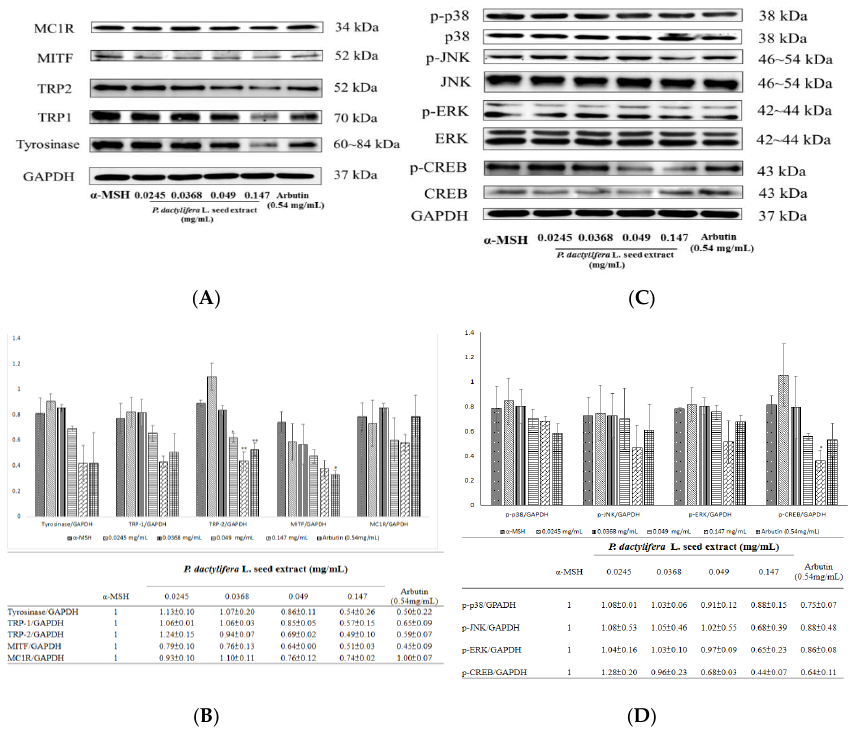
Figure 5. The effects of P. dactylifera L. seed extract on melanogenesis-related protein expression and signaling pathways. ( A , C ) Western blotting of cellular proteins in B16F10 cells. ( B , D ) The relative amounts of MITF, tyrosinase, MC1R, TRP1, and TRP2 or phosphorylated proteins (p-p38, p-JNK, p-ERK, and p-CREB) compared to total GAPDH were calculated and analyzed using Multi Gauge 3.0 software, and the values are represented as the means of triplicate experiments with standard deviations. * p < 0.05, ** p < 0.01.